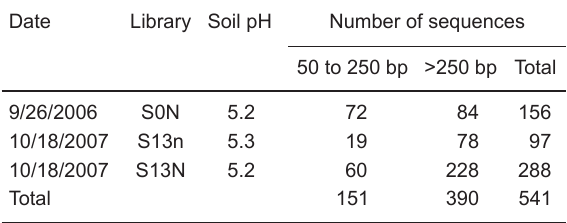
Table 1. Soil samples of sugarcane rhizosphere and the number of 16S rRNA gene sequences.